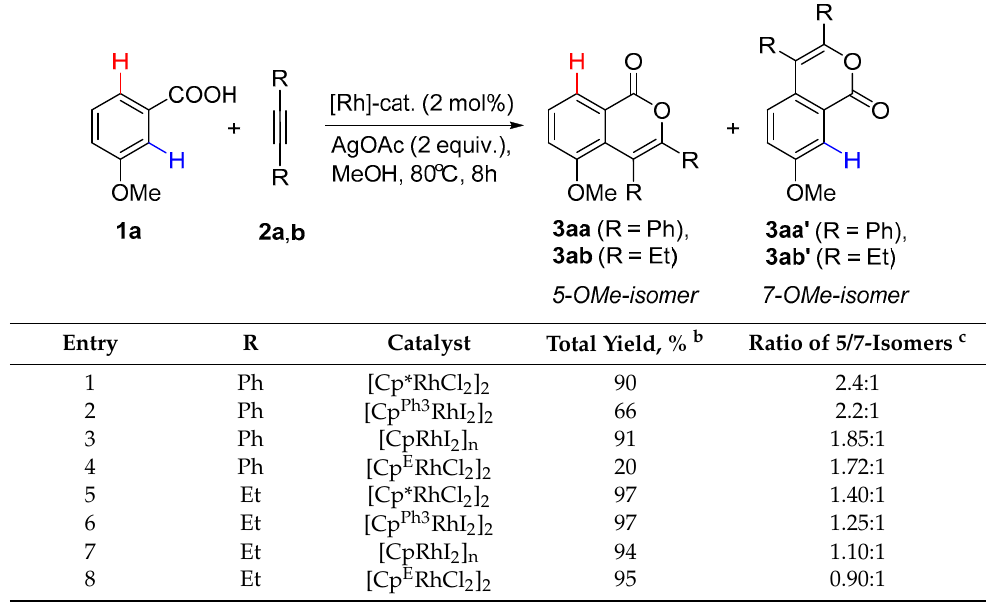
Table 1. Catalyst screening in the annulation of 3-methoxybenzoic acid 1a with alkynes a .